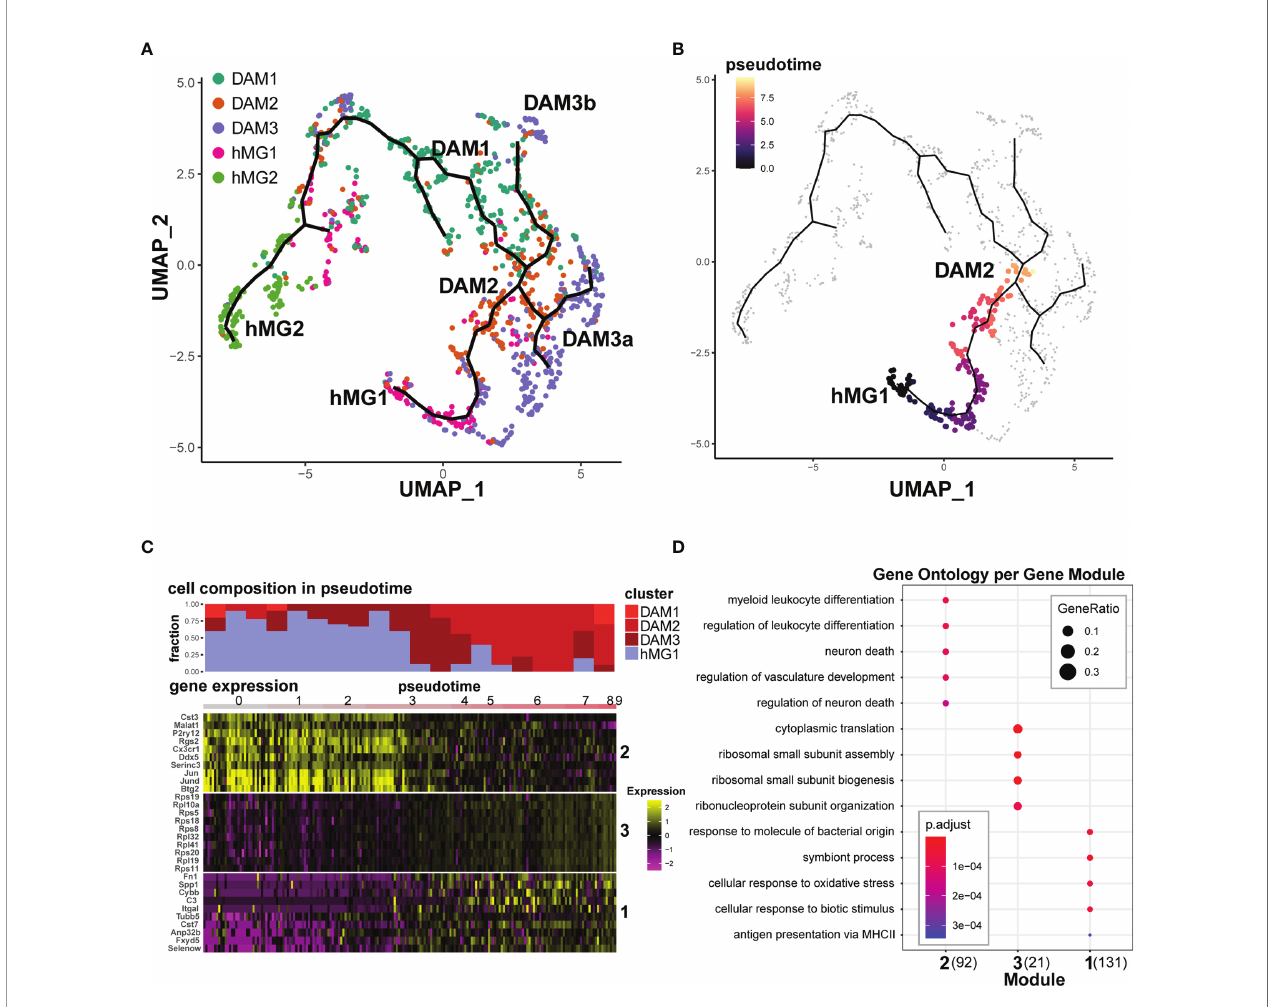
FIGURE 6 | Transcriptional trajectories of microglia in EAE reveal distinct homeostatic inputs that converge upon disease-associated states. Select Seurat v3- de fi ned microglial cell clusters (hMG1, hMG2, DAM1,2,3) were analyzed using Monocle 3, as described in the Materials and Methods. (A) Monocle 3-inferred transcriptional trajectories. (B) Trajectory between hMG1 and DAM2, manually selected for pseudotime analysis in (C, D) . (C) Top - cell composition over pseudotime along the hMG1 > DAM2 trajectory. Bottom – gene expression modules signi fi cantly associated with pseudotime. Heatmap shows gene expression for top 10 genes (ranked by Moran ’ s I statistic) for each module. (D) GO analysis of modules identi fi ed in (C) . The number in parentheses indicates the number of genes in each